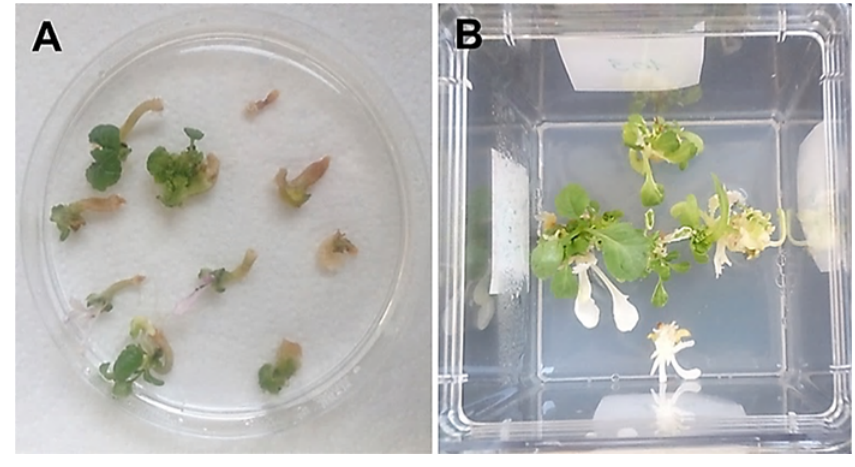
Figure 7 Regeneration of transgenic haploid winter oilseed rape. ( A ) Transformed microspore-derived embryos (MDEs) on a selection medium supplemented with kinetin. ( B ) Plantlet development from transformed MDEs on stable medium MS with kinetin and timentin. Photographs from the archives of the Department of Oilseed Crops, Plant Breeding and Acclimatization Institute – National Research